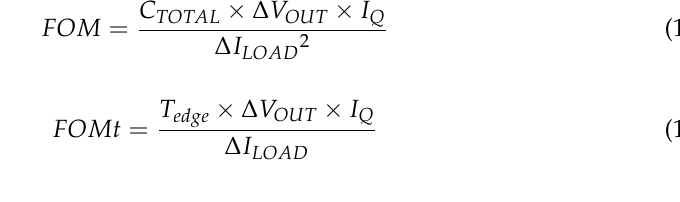
Table 1. Comparison of state-of-the-art low-power